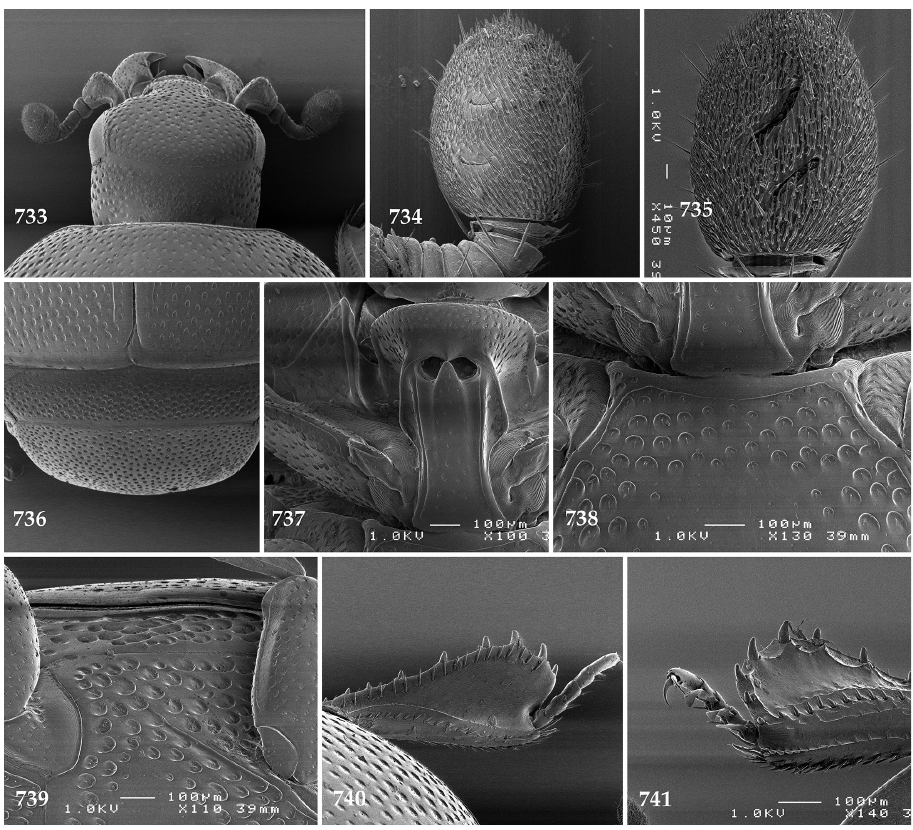
Figures 733–741. 733 Tomogenius ripicola (Marseul, 1870) head, dorsal view 734 antennal club, dorsal view 735 ditto, ventral view 736 propygidium + pygidium 737 prosternum 738 mesoventrite 739 lateral disc of metaventrite + metepisternum 740 protibia, dorsal view 741 ditto, ventral